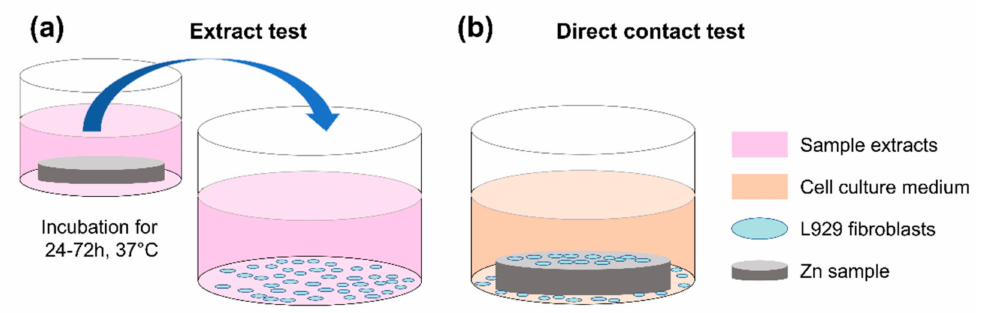
Figure 1. Schematic diagram of test methods for cytotoxicity evaluation of Zn–based BMs: ( a ) extract test and ( b ) direct contact